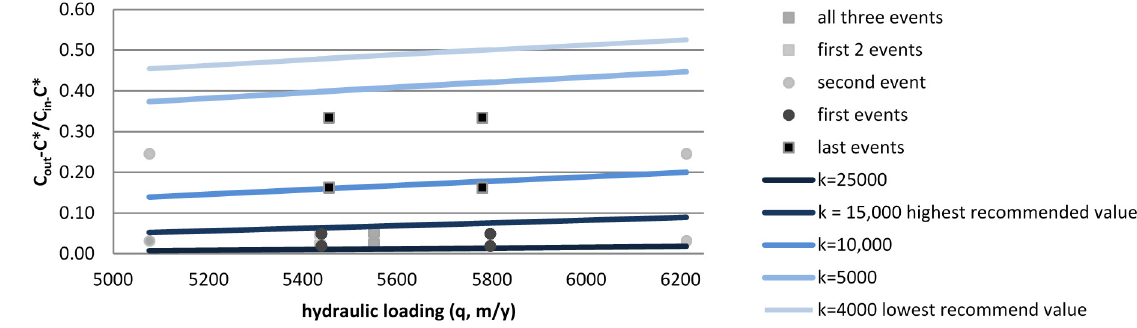
Figure 6. Pollutant concentration change relative to hydraulic loading across the